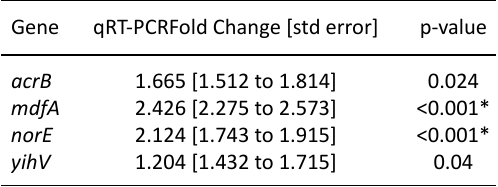
Table 6. Analysis of the relative gene expression of E. coli (n=8) after TCS adaptation